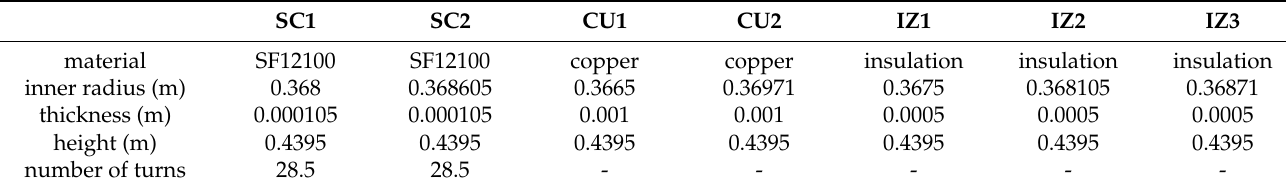
Figure 8. ( a ) Geometry of the numerical model (proportions are not correct). The sizes are in Table 2. ( b ) Electrical circuit diagram of the numerical model. Table 2. Geometric parameters of the areas of the numerical